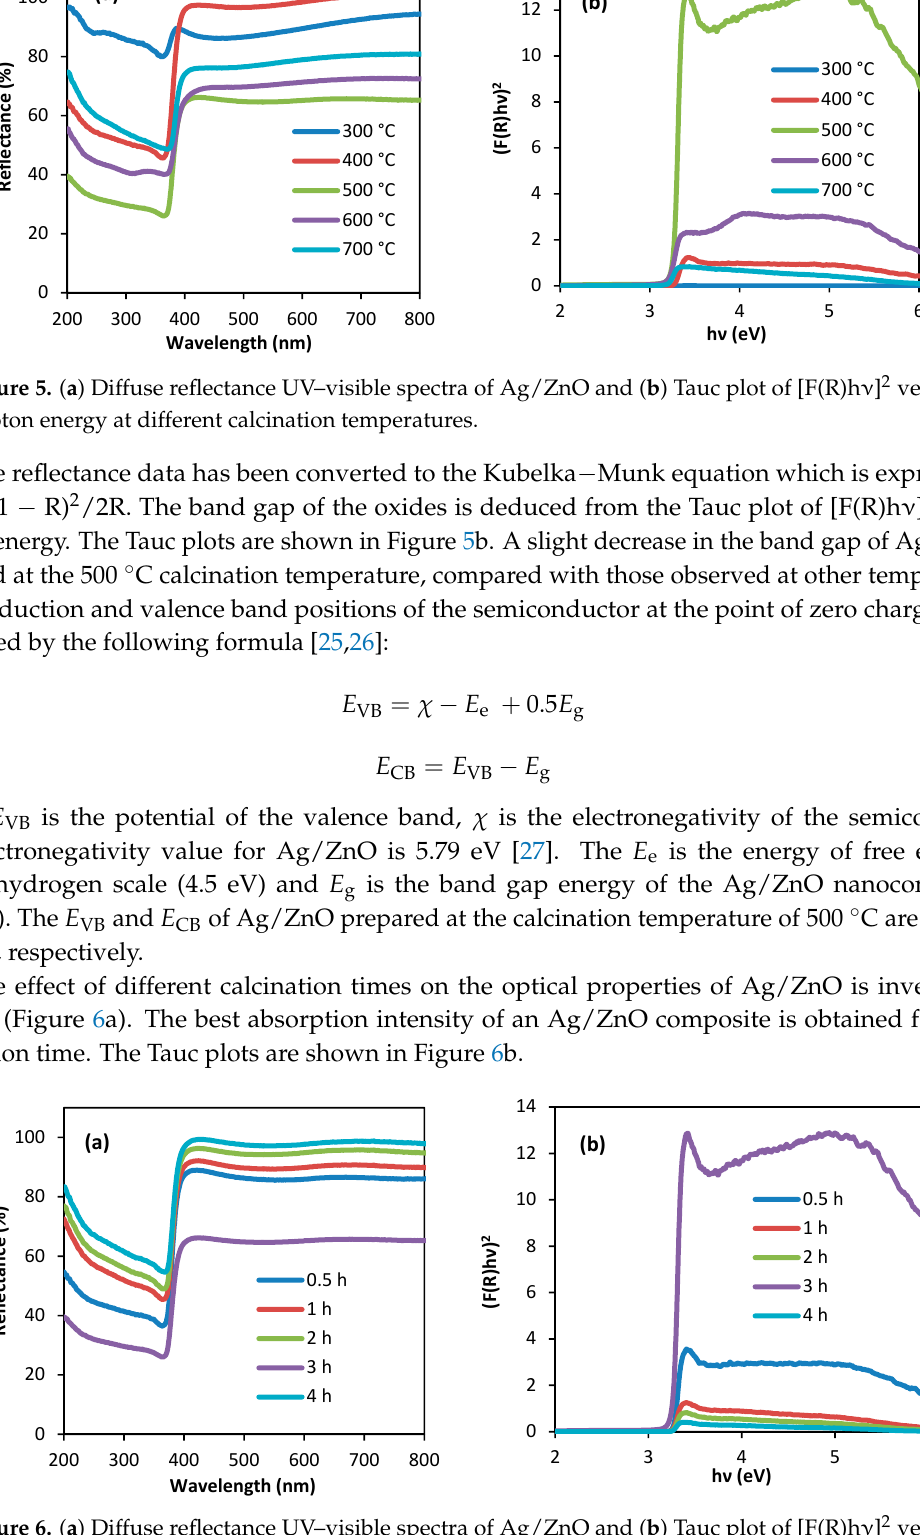
Figure 6. ( a ) Diffuse reflectance UV–visible spectra of Ag/ZnO and ( b ) Tauc plot of [F(R)h ν ] 2 versus photon energy at different calcination times.